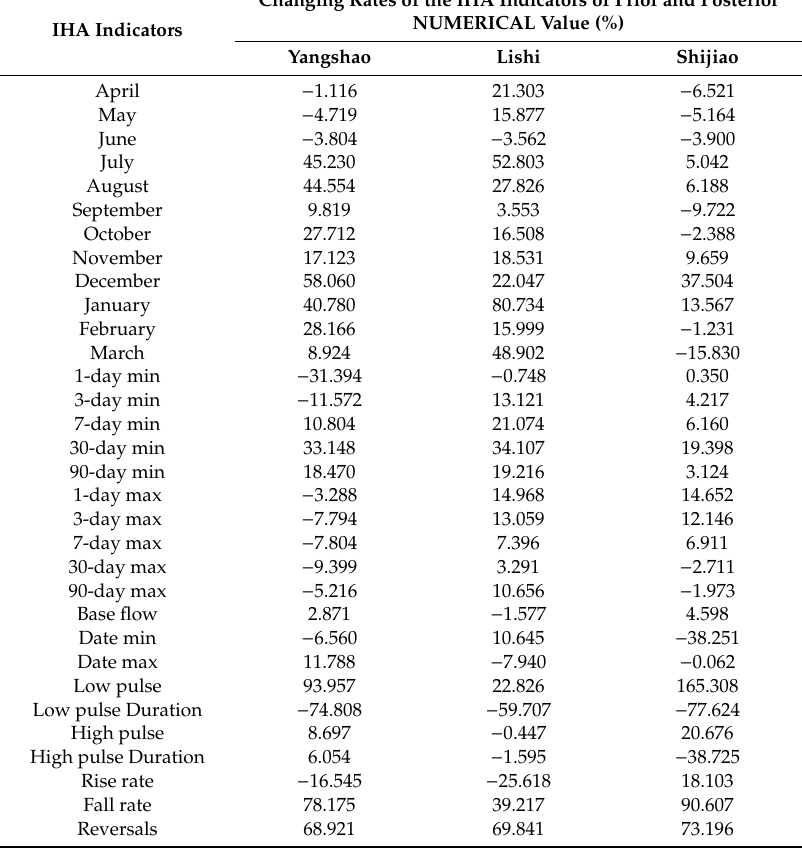
Table 3. The changing rates comparing of prior and posterior numerical value based on the IHA indicators (darker shading indicates higher group).